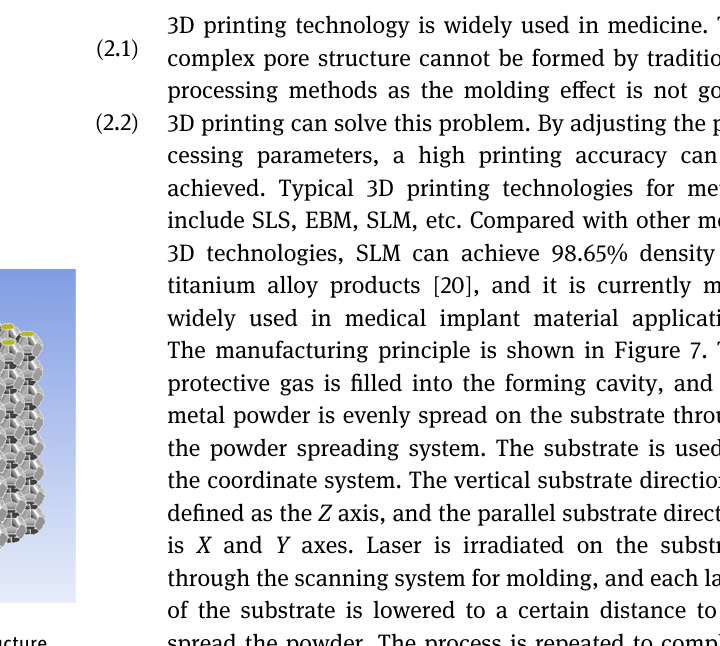
Figure 4: Boundary condition setting of porous